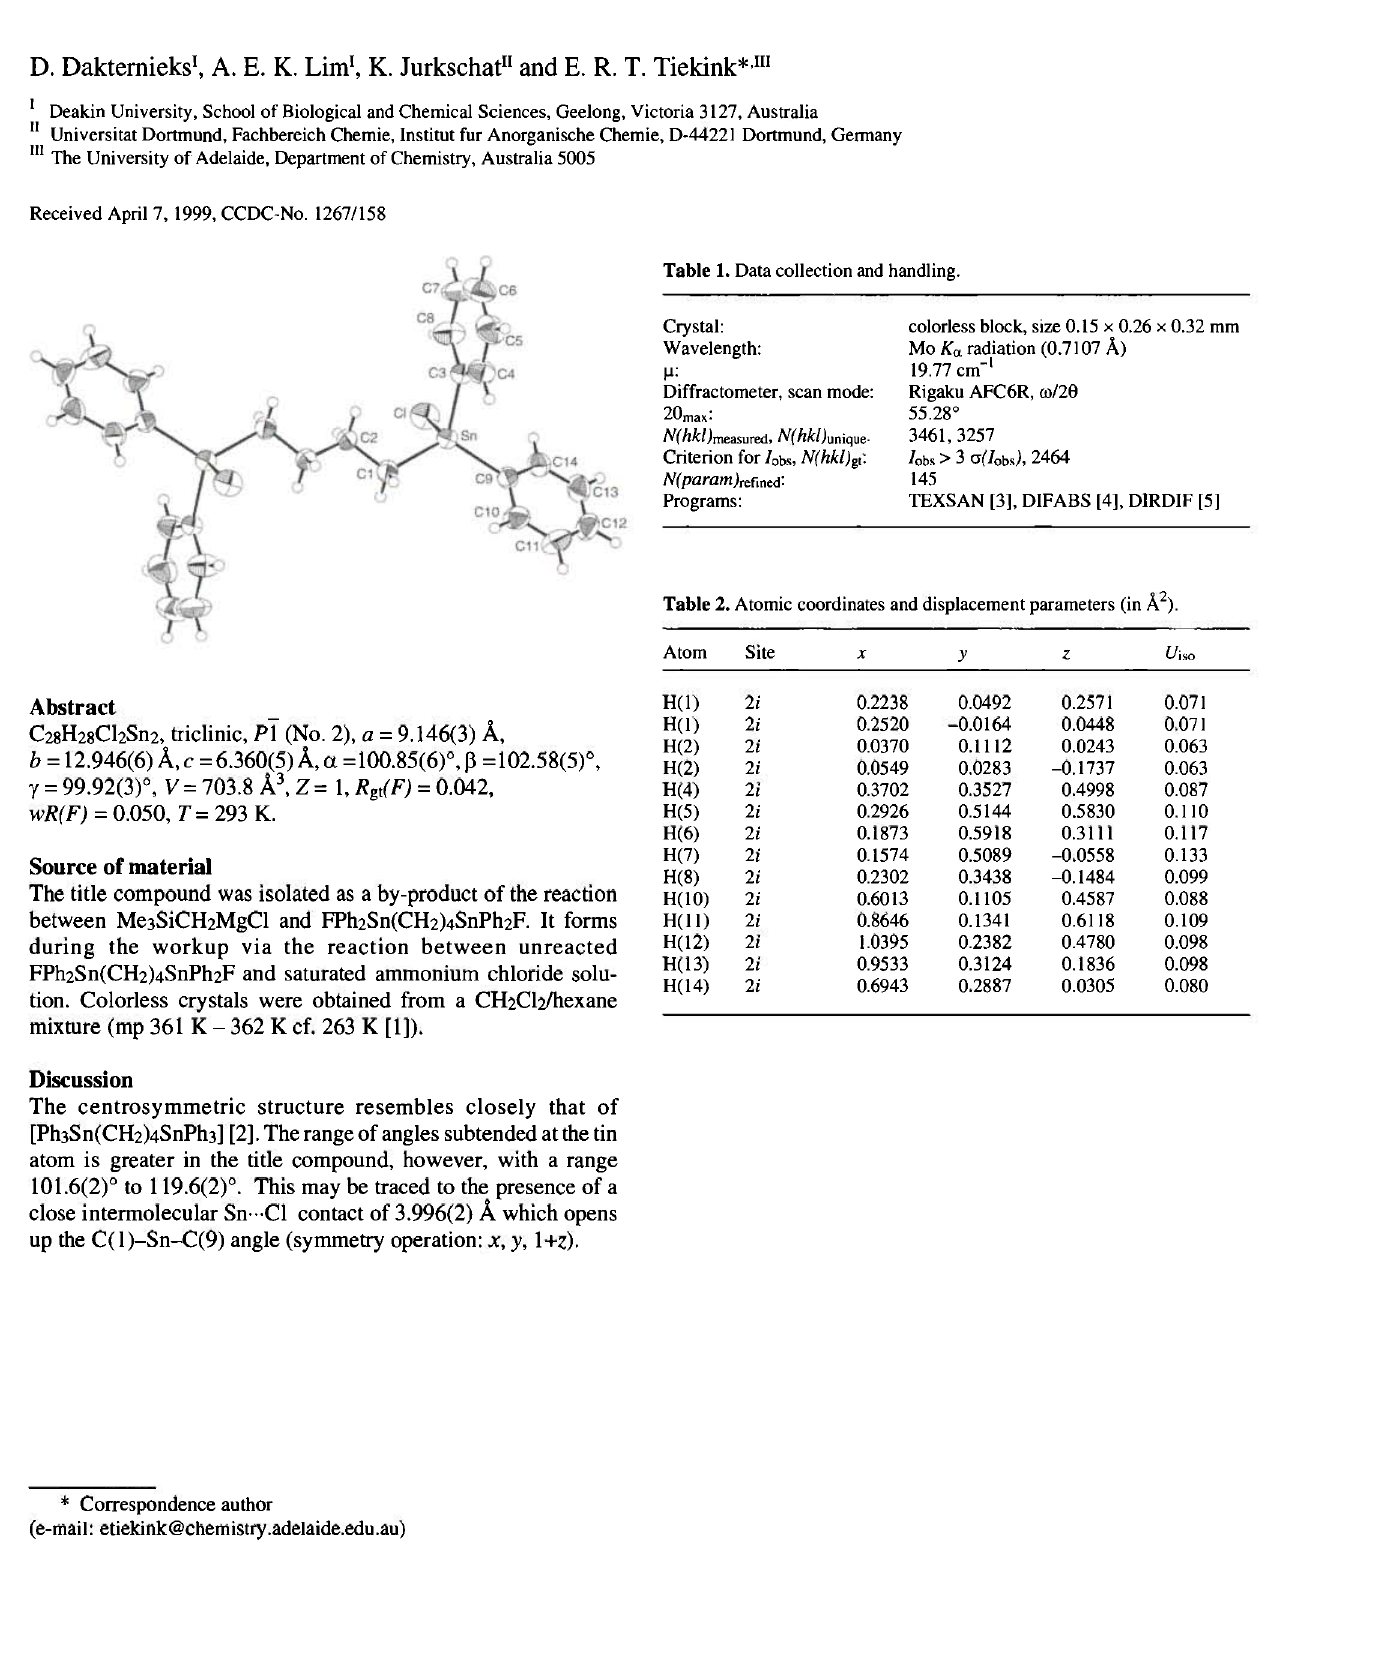
Table 2. Atomic coordinates and displacement parameters (in Ä 2